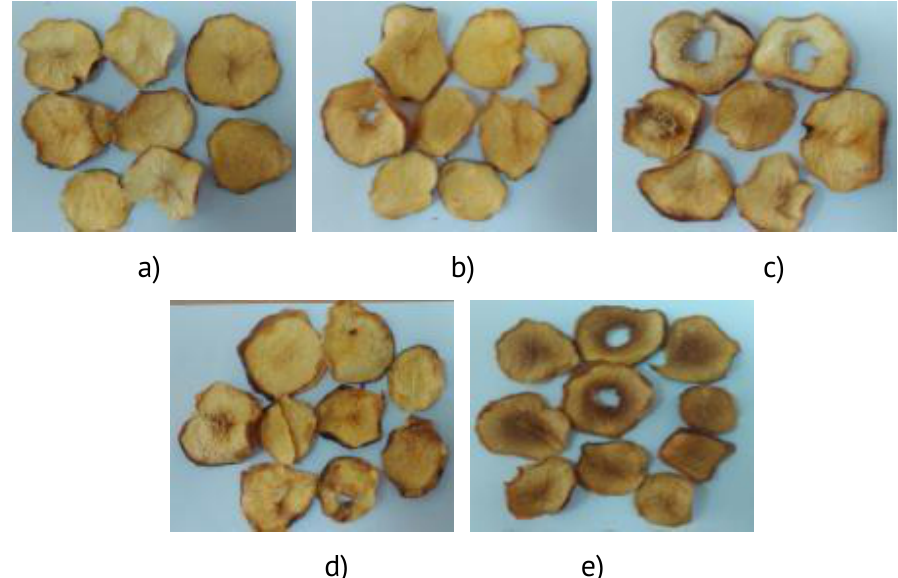
Figure 12. SPRINGCREST peaches aspect dried using: thermal agent 2.0 m/s velocity and 60.0% relative humidity: a) 50°C; b) 60°C; c) 70°C; d) 80°C; e) 90°C